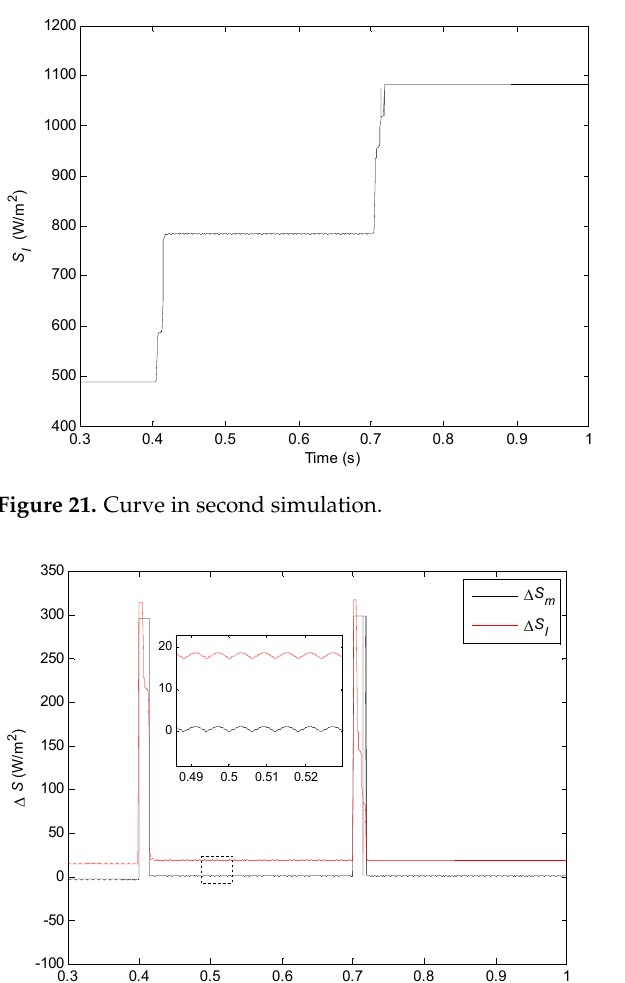
Figure 20. Curve in second simulation.